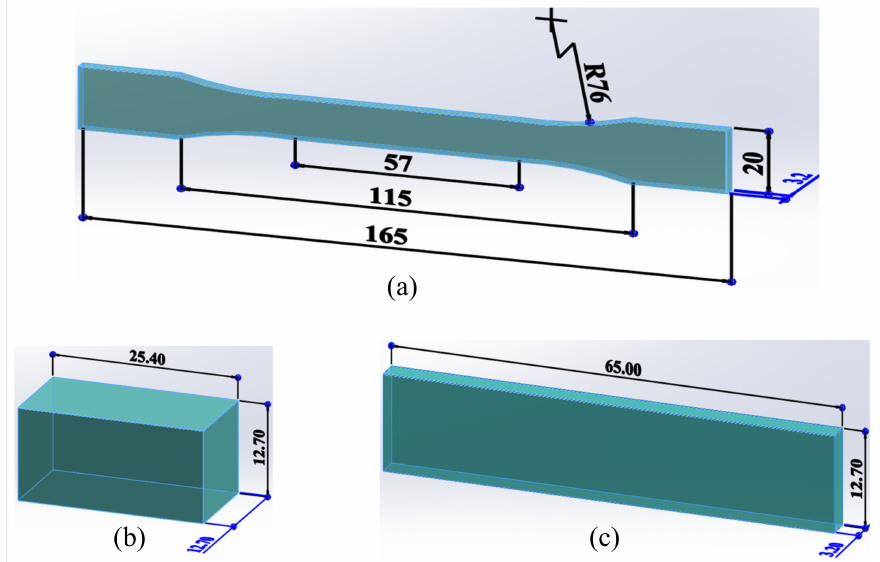
Figure 3. Geometry of experimental specimens: ( a ) tensile, ( b ) compressive and ( c ) flexural.